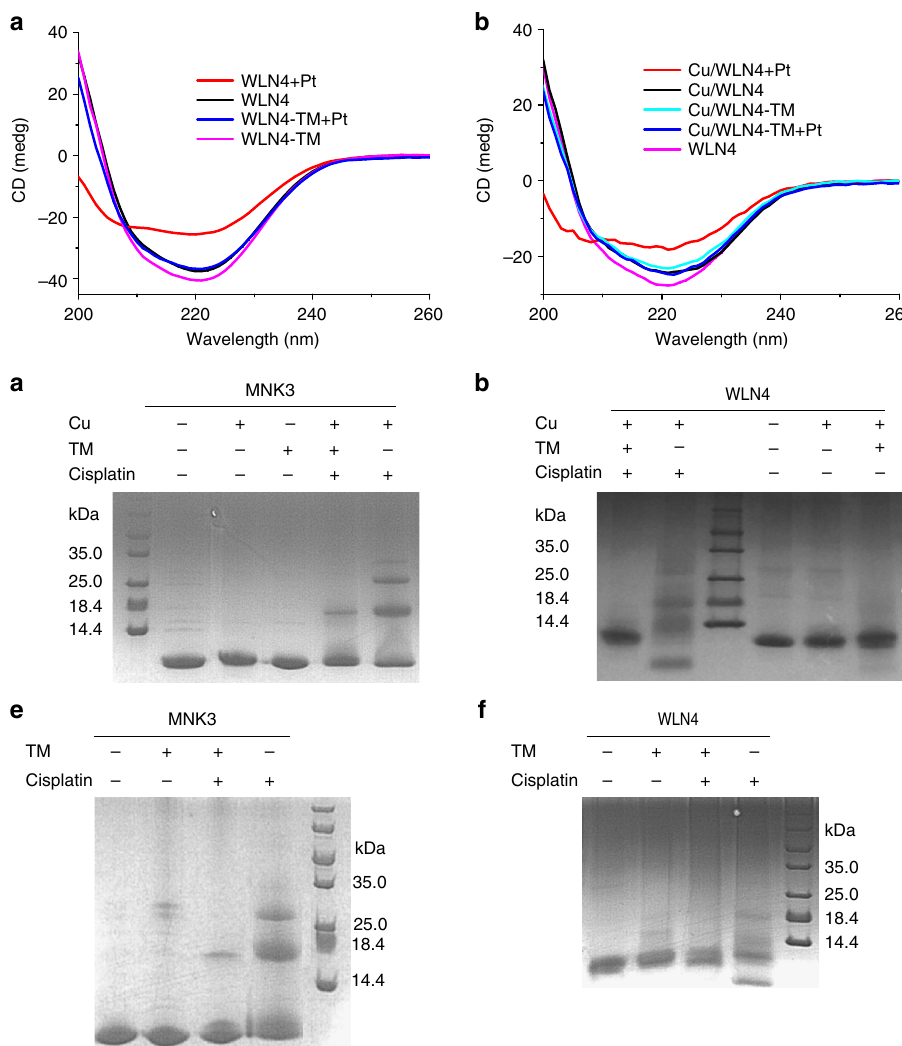
Fig. 4 TM inhibition of the protein aggregation induced by cisplatin. a , b CD spectra of WLN4 ( a ) or Cu-WLN4 ( b ). TM-WLN4 complexes were prepared by reaction of the protein with 3 eq. TM for 3 h at 37 °C. The protein platination was performed by incubation with 3-molar equivalents of cisplatin for 8 h. c – f Gel electrophoresis analysis of the protein aggregation inhibited by TM. c Cu-MNK3; d Cu-WLN4; e apo-MNK3; f apo-WLN4. The copper protein was prepared by incubation with 1.5-fold Cu for 15 min at room temperature. Proteins (200 µ M) were reacted with TM (600 µ M) for 3 h, then were incubated with cisplatin (600 µ M) for 2 h. Reactions were performed in 50 mM MES, 150 mM NaCl, pH 6.0 at 37 °C. Symbols + /- indicate presence/absence of the